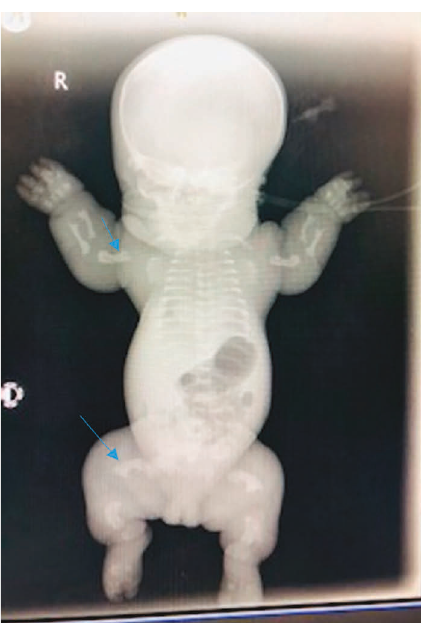
Figure 1: Plain radiograph of baby 1 with features of TD type 1. Arrows show telephone-handle shaped humerus and